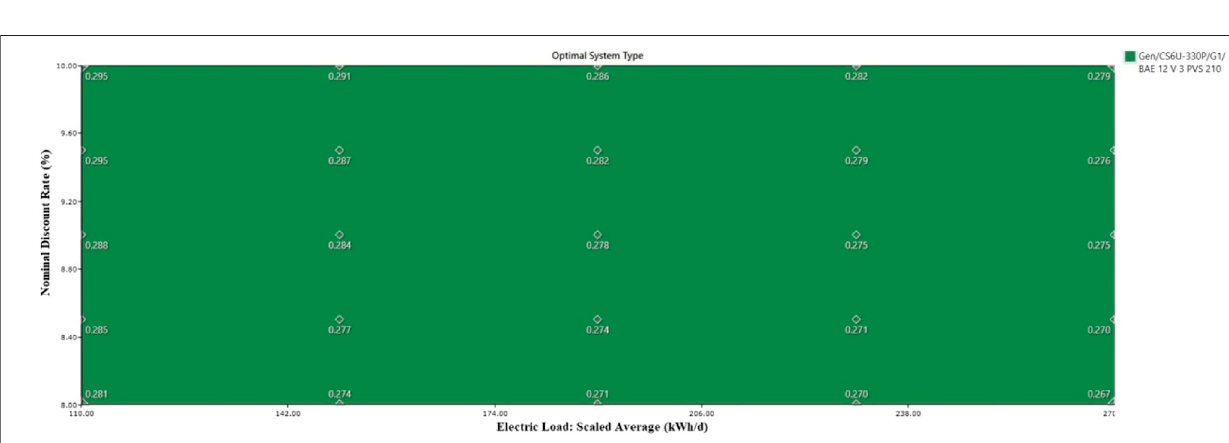
FIGURE 16 | Optimal system type: scaled annual average electric load vs. NDR at a project lifetime of 25 years; superimposed: COE.